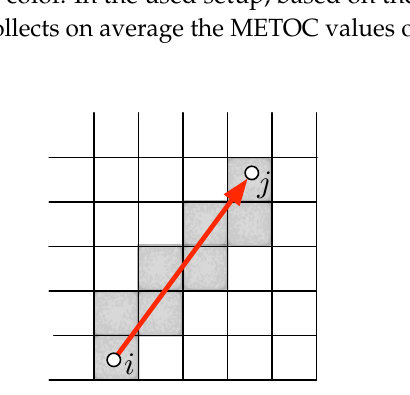
Figure 6. Schematic representation of the METOC grid cells touched by an edge (highlighted in grey color) connecting two nodes of the spatial graph